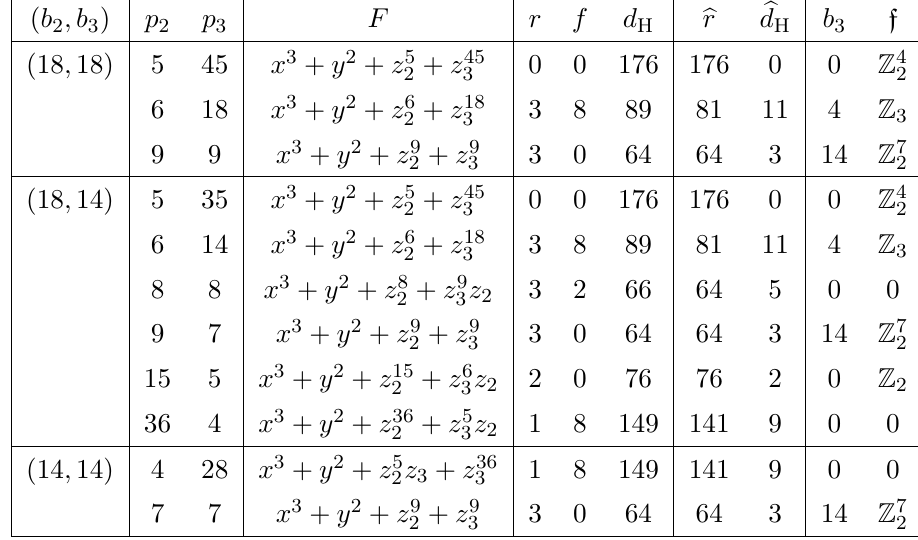
Table 22 . G = E 7 with b 1 = 14